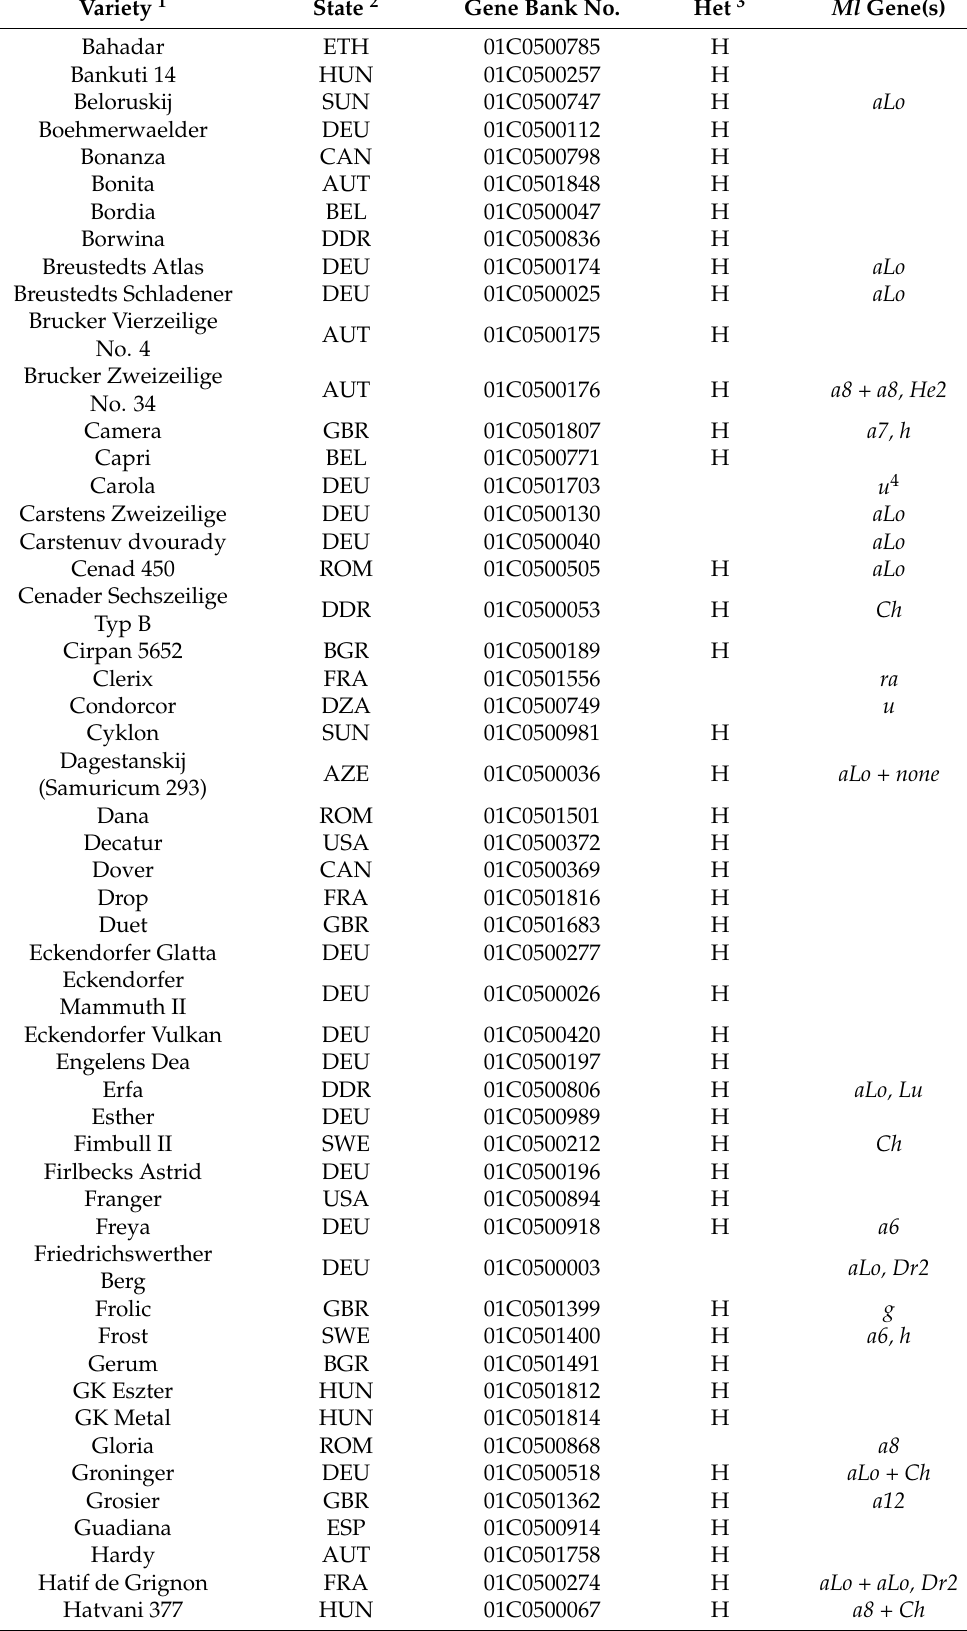
Table 2. Cont. Variety 1 State 2 Gene Bank